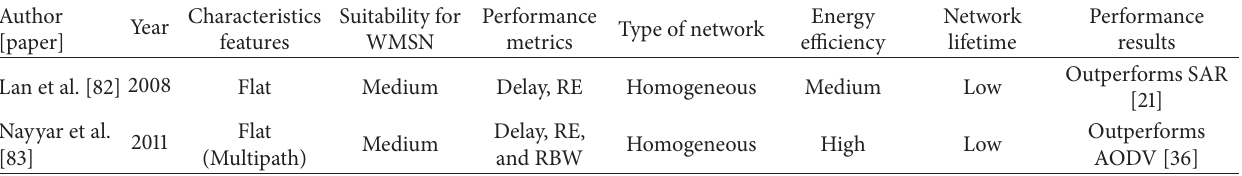
Table 5: Flat routing protocols.